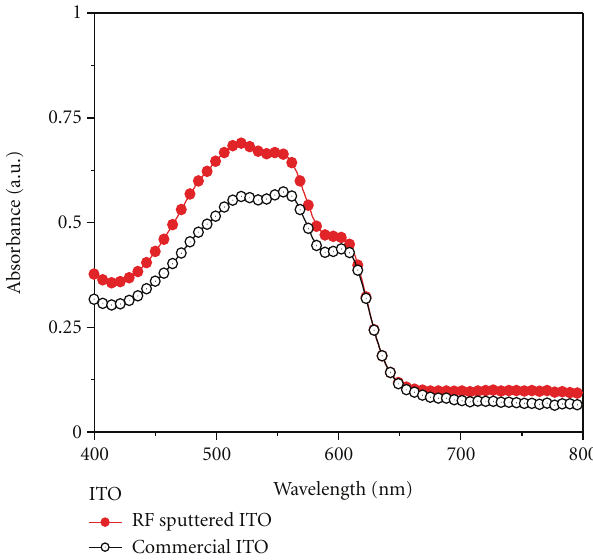
Figure 6: Absorption spectra of the devices fabricated on commer- cial and RF-sputtered ITO thin films.